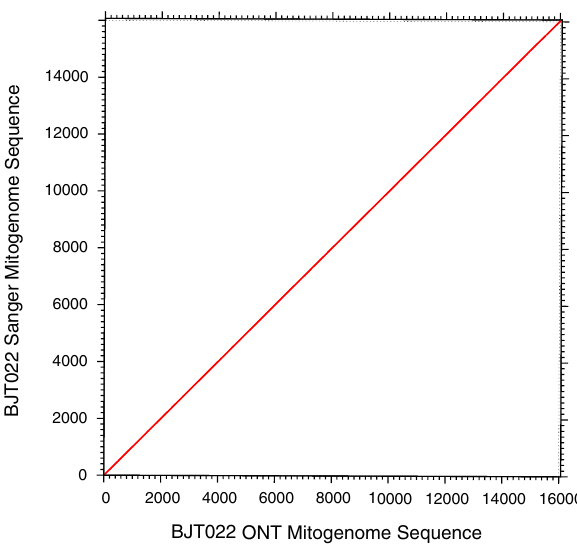
Figure 2. Dot plot of pairwise alignment of the mionION and Sanger sequence Callithrix mitogenome of marmoset BJT022. The alignment was produced in MAFFT.